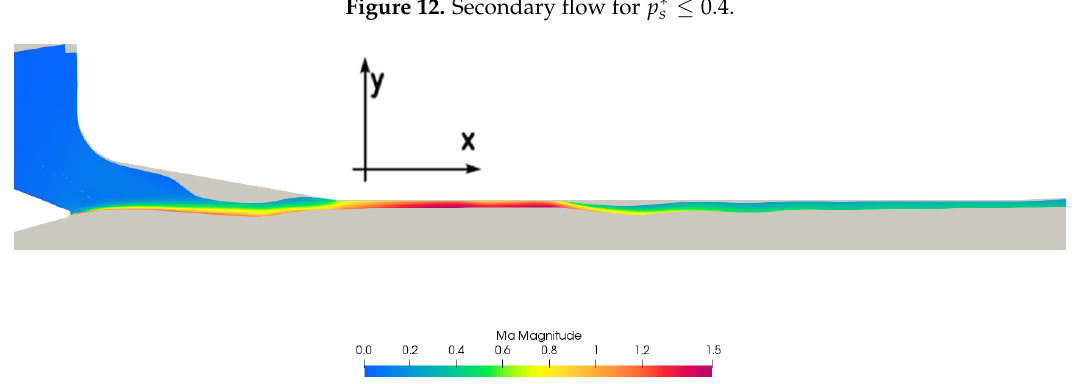
Figure 12. Secondary flow for p ∗ s ≤ 0.4.